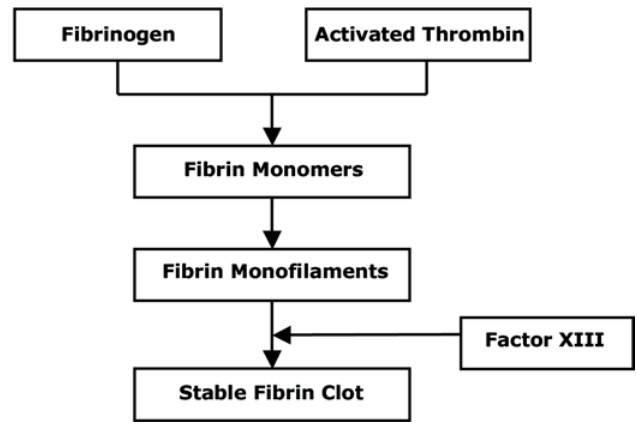
Figure 1 – Mechanism of action of liquid fibrin sealant in recapitulating the terminal portion of the coagulation cascade.